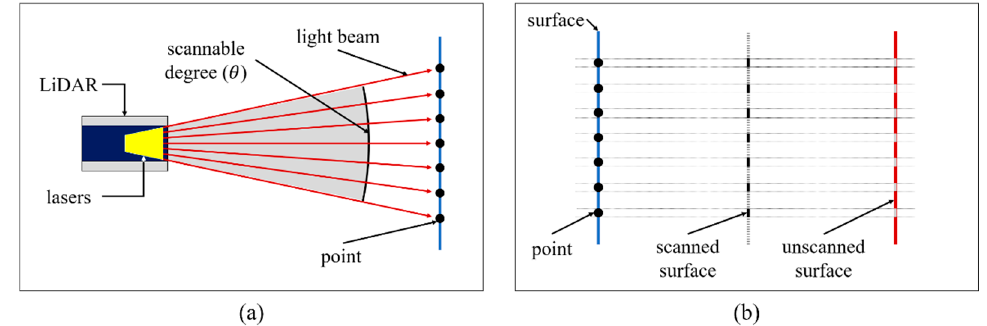
Figure 4. ( a ) Scanning process of LiDAR; ( b ) Scanned surface of object.